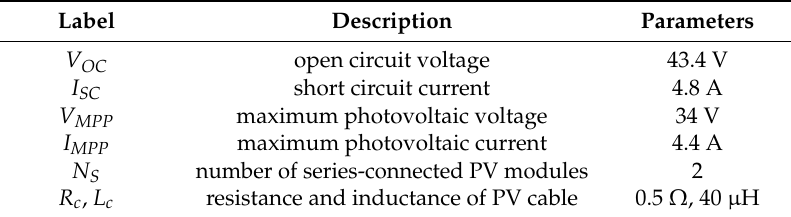
Table 3. PV source parameters—Standard test conditions (STC).